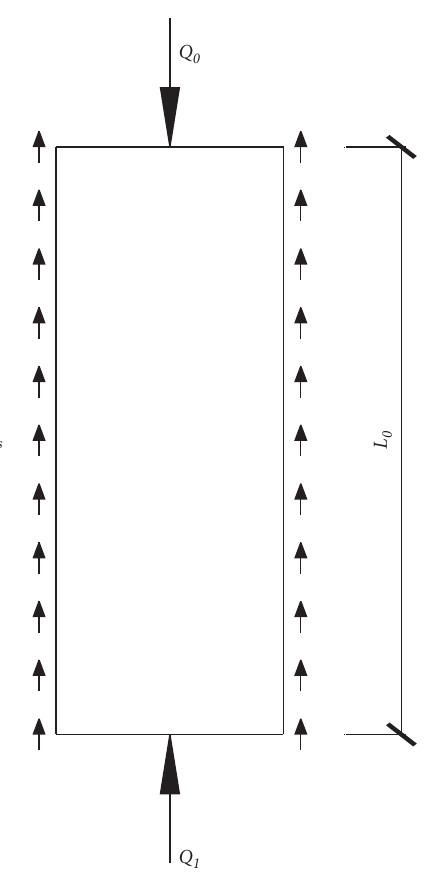
Figure 5: Pile stress unit.